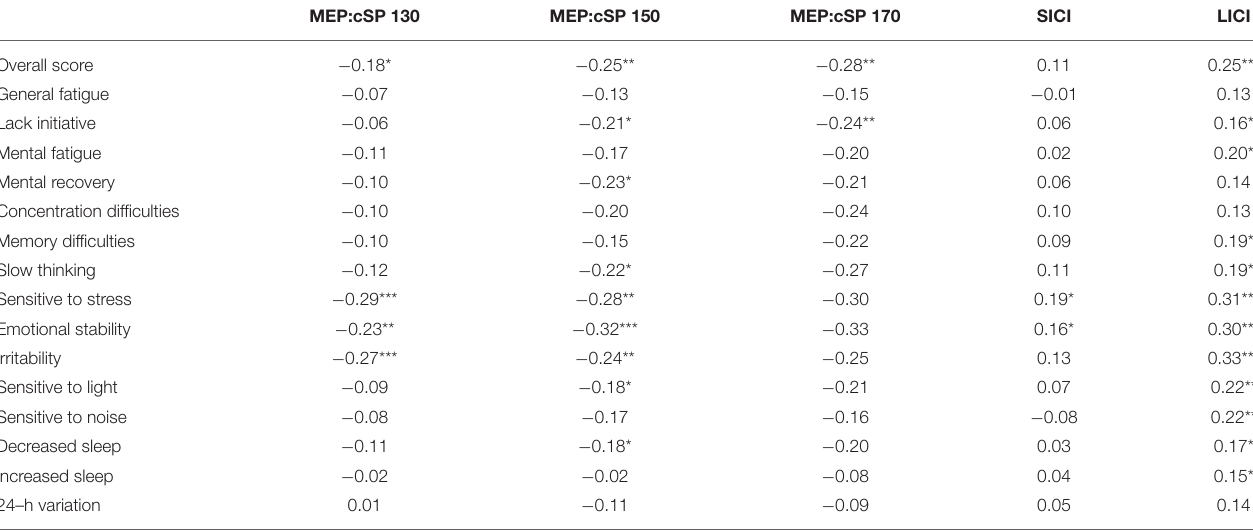
TABLE 3 | TMS and Self-reported symptoms from all participants who reported concussions ( n = 122).